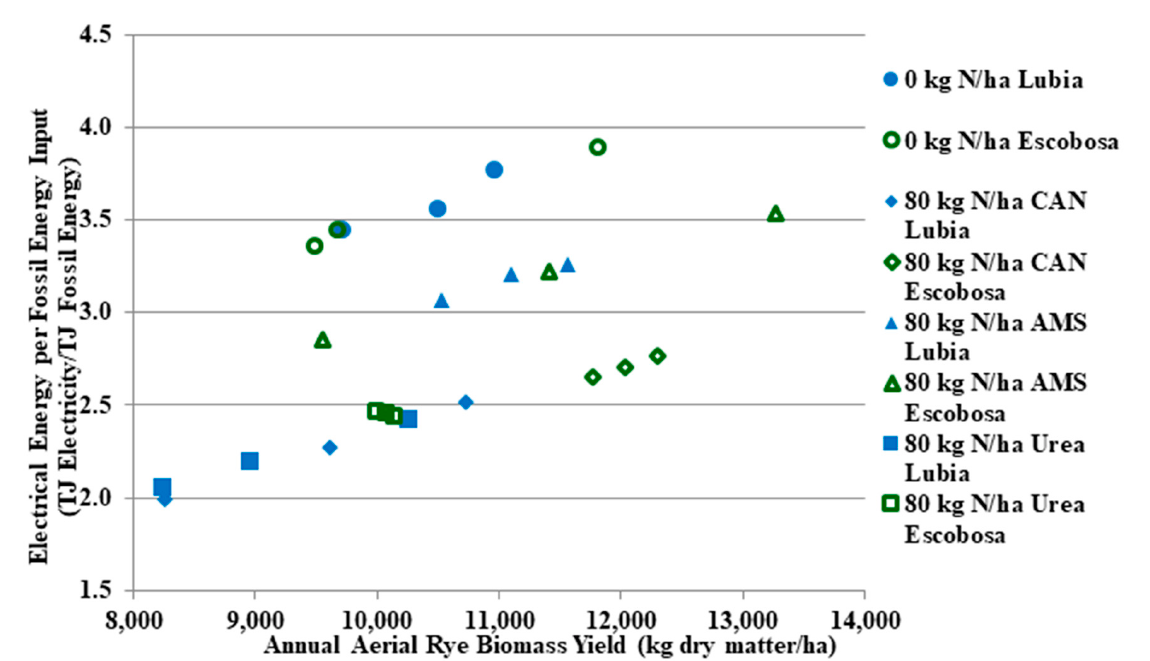
Figure 4. Relationship between the electrical energy produced per fossil energy consumed as a function of the biomass yields obtained from the rye energy crops grown under different fertilizer regimes. CAN: calcium ammonium nitrate, AMS: ammonium sulphate.